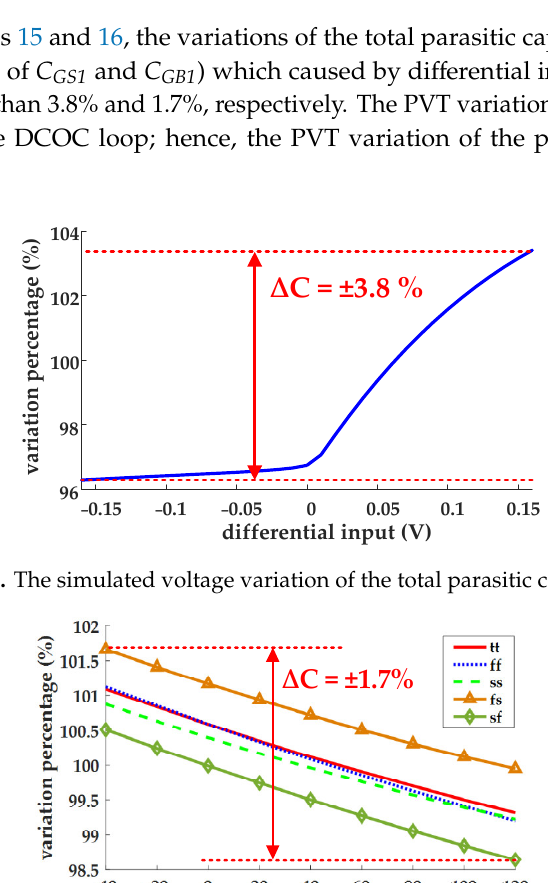
Figure 14. A schematic of the DC offset cancellation (DCOC) circuit.